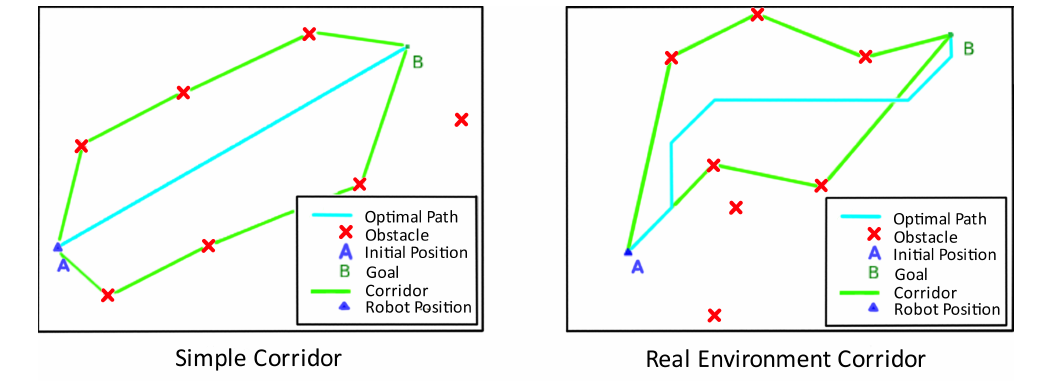
Figure 3. Examples of corridors.